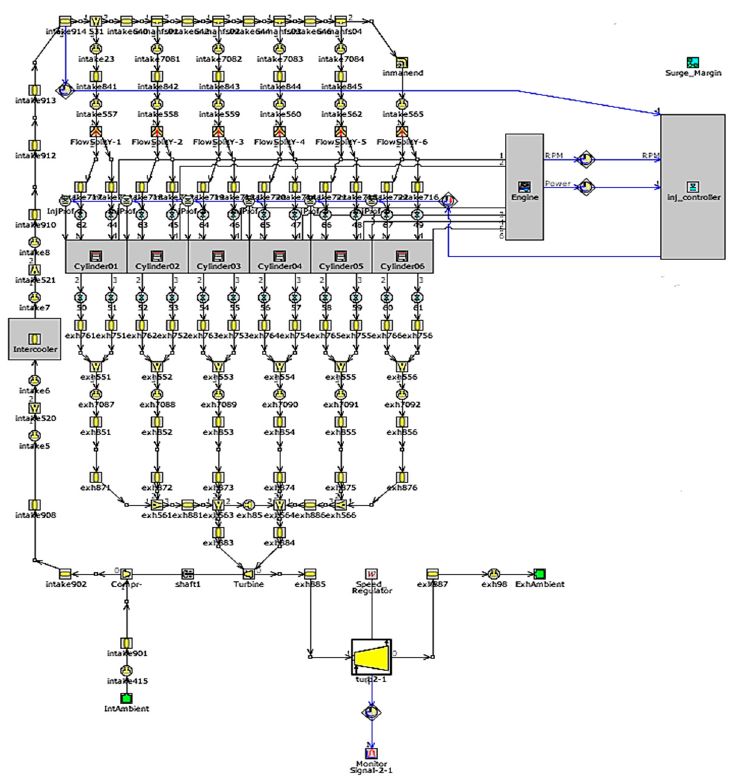
Figure 8. Turbo-compound system model.